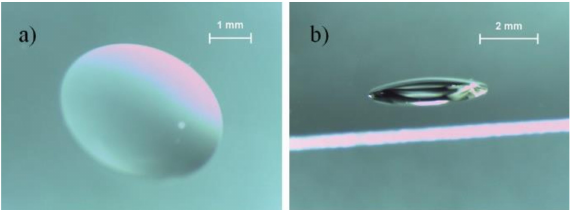
Figure 4. Photographs of the µ -lens produced, obtained with a Leica M80TM stereo microscope: ( a ) top view and ( b ) side view.